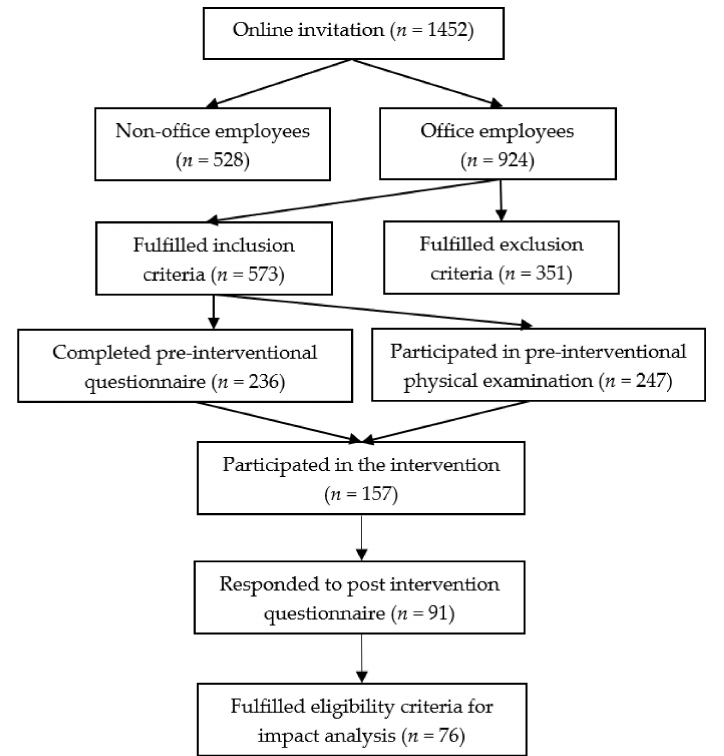
Figure 1. Flow diagram of subject selection for the